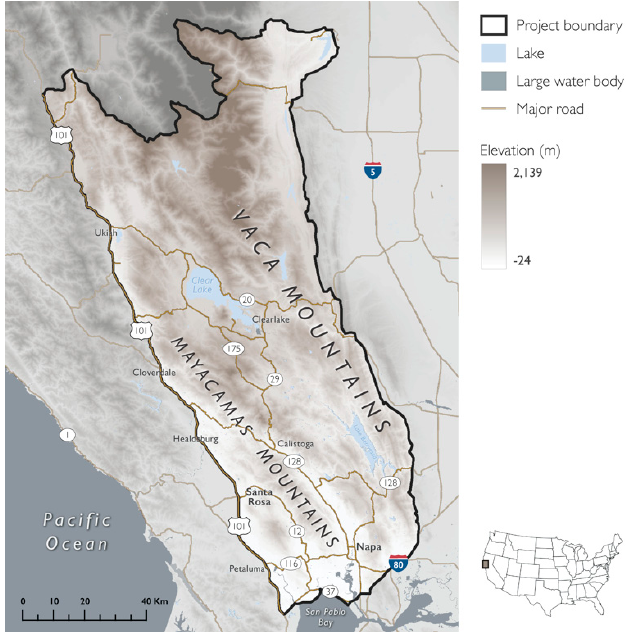
Figure 1. Project area featuring topographic diversity and coastal influence. Map of the Mayacamas to Berryessa project area spanning the Mayacamas and Vaca Mountains, overlaid with elevation. The western boundary coincided with a major highway, U.S. Route 101, and was approximately 35 km from the Pacific Ocean. The lowest elevation (white) in the southwest near San Pablo Bay and the highest elevation (brown) was in the northeast at Snow Mountain East (range = 2115 m).